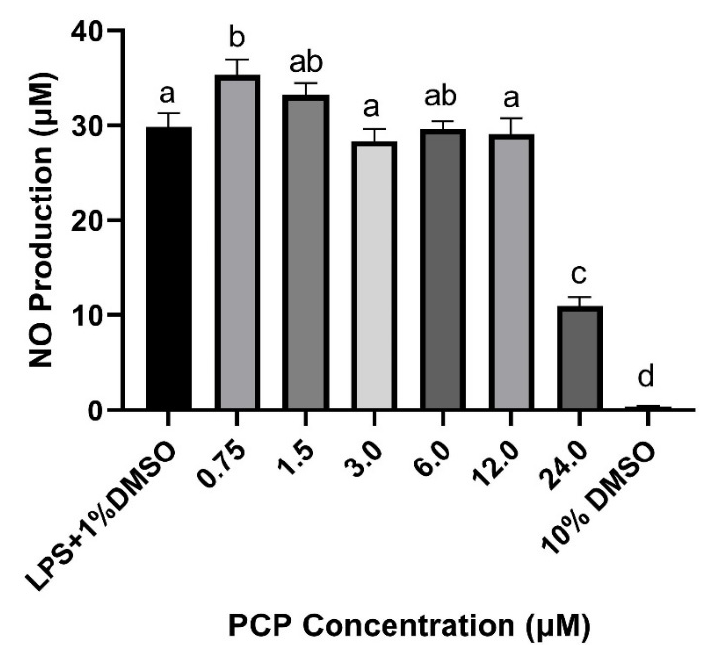
Figure 6. Anti-inflammation potential of purified PCP on lipopolysaccharide (LPS) stimulated NO production in RAW 264.7 macrophage cells. Results represent the mean ± SD of three replicates. Different superscript letters on column bars denotes significant difference at p < 0.05.